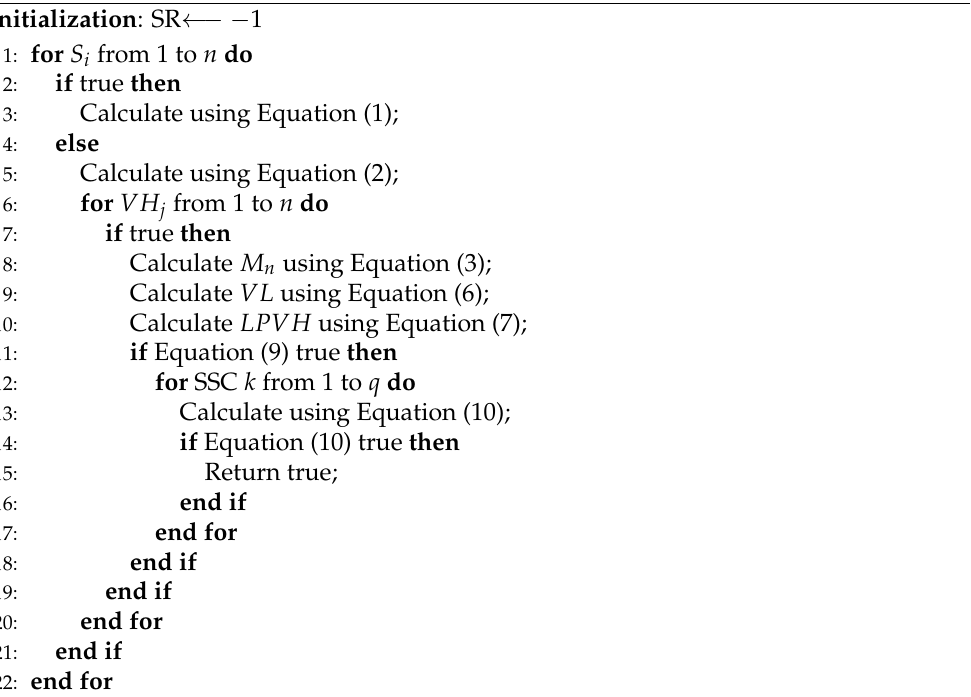
Algorithm 1 Anti-fragile and resilient service delivery in fog